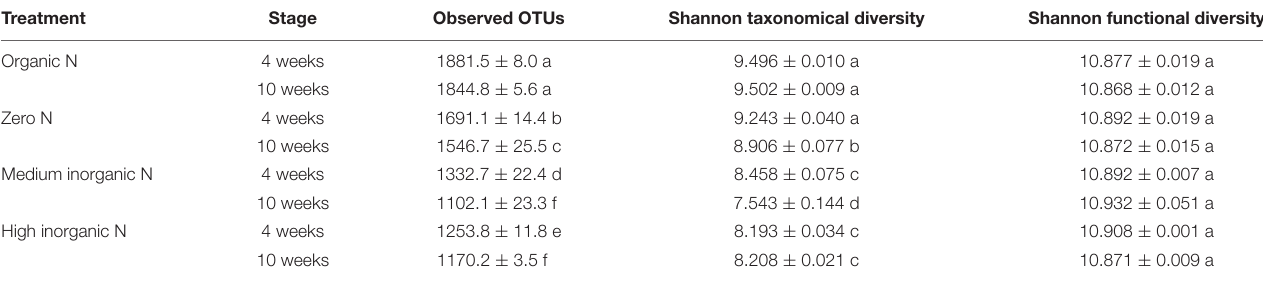
FIGURE 3 | PCoA plots based on Bray-Curtis distance matrix of bacterial communities associated with wheat grown in soils under different fertilization regime. Each fertilizer treatment is represented in one PCoA: (A) – organic N; (B) – zero N; (C) – medium inorganic N; (D) – high inorganic N. The percentage shown in each axis corresponds to the proportion of variation explained. Solid squares represent rhizosphere collected after 4 weeks; solid circles represent rhizosphere samples collected after 10 weeks; open squares indicate bulk soil samples collected after 4 weeks and open circles indicate samples collected after 10 weeks. TABLE 3 | Data are presented as means ± standard errors calculated for observed OTUs and Shannon diversity and functional indexes of rhizosphere bacterial communities associated with wheat grown in soils under different fertilization regimes (organic N, zero N, medium inorganic N, and high inorganic N), collected after 4 and 10